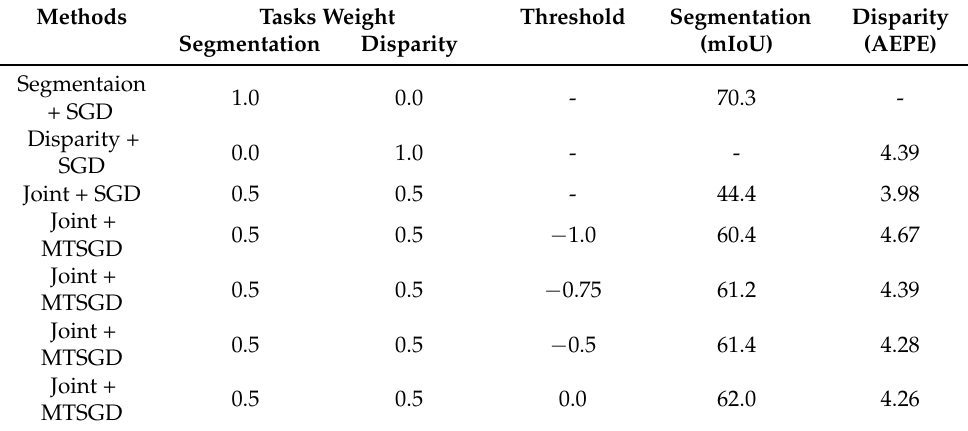
Figure 7. Performance profile for Disparity Estimation–Semantic Segmentation. Table 2. Investigation of gradients balance and gradient clipping for MTSGD. ’Segmentation + SGD’ and ’Disparity + SGD’ denote a single task model of semantic segmentation and disparity estimation, respectively. Both of them are trained using the original SGD optimization algorithm. ’Joint + SGD’ denotes the joint learning of semantic segmentation and disparity estimation with the original SGD algorithm, and ’Joint + MTSGD’ denotes the model that is trained with our proposed MTSGD optimization algorithm. ’Threshold’ denotes the threshold for gradient clipping based on the similarity of the sub-gradient of different